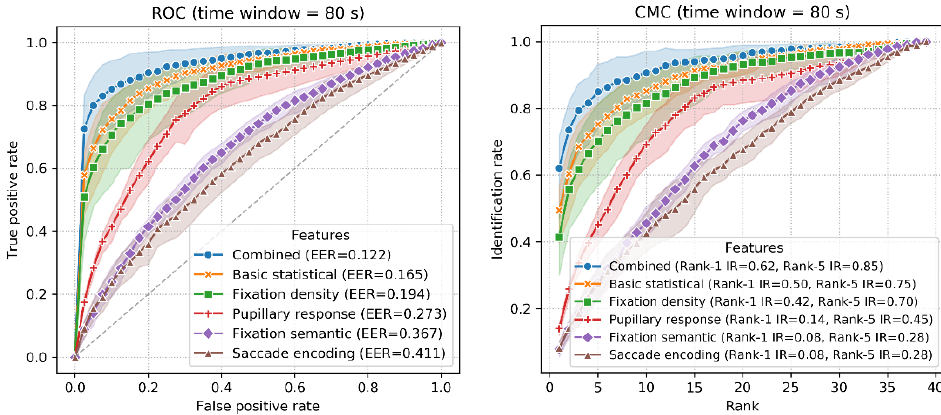
Figure 10. ROC ( left ) and CMC ( right ) curves using the LORO classification (T win = 80 s).